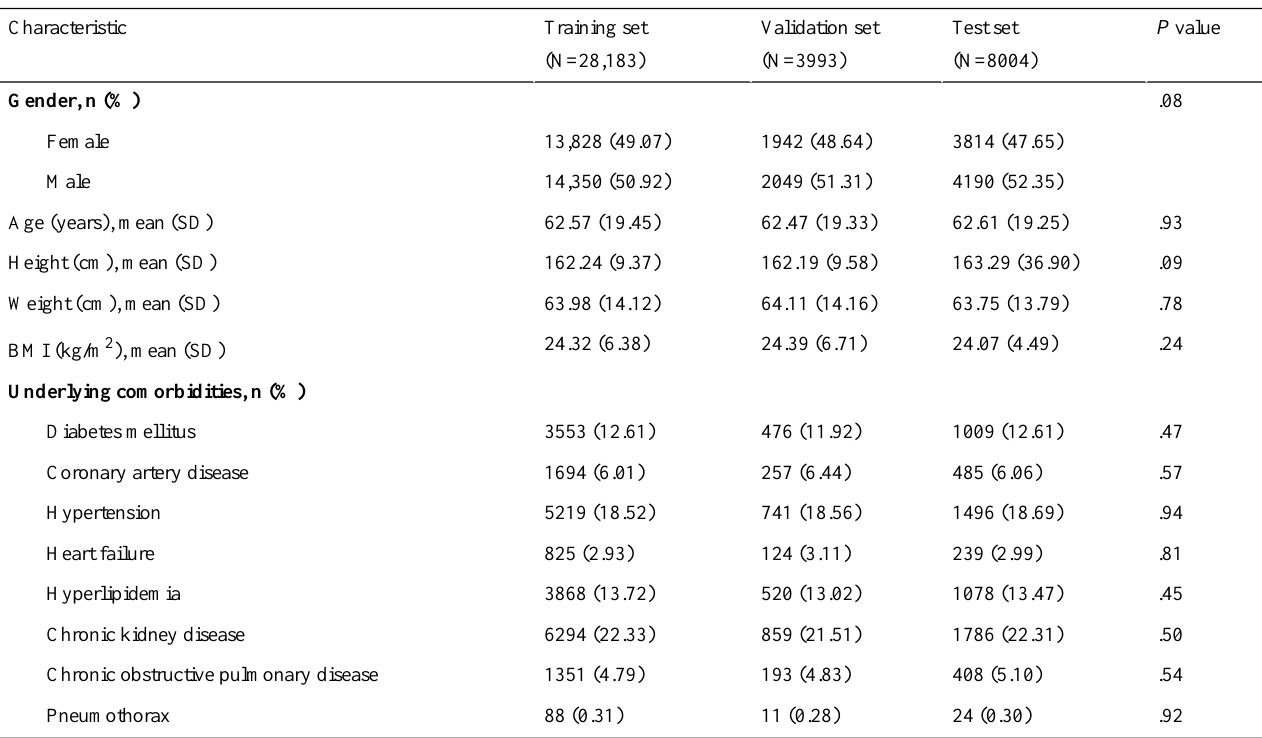
Table 1. Patients’characteristics in the training, validation, and test